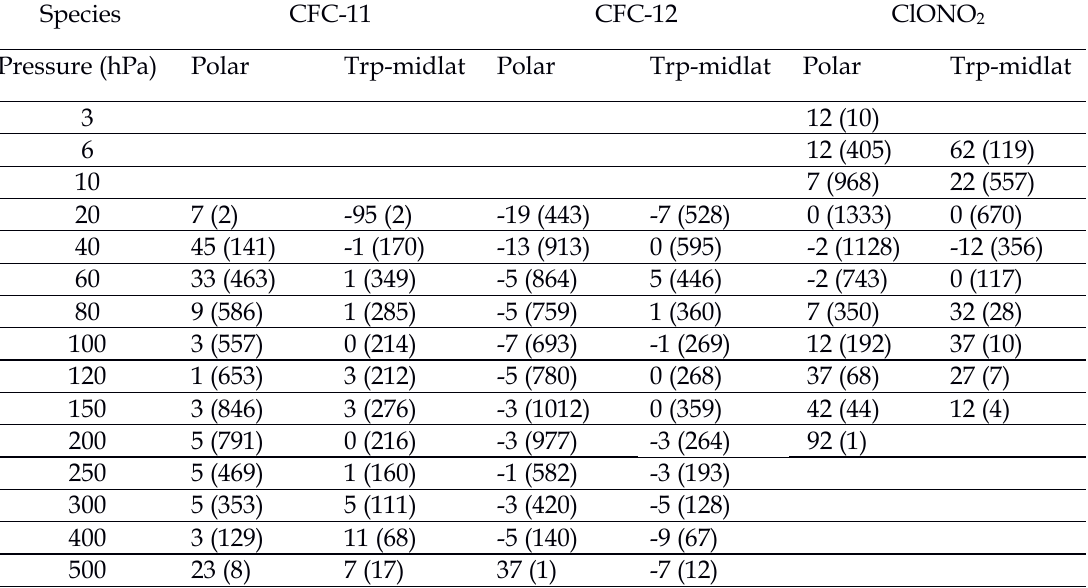
Table 1: Percentage median of the differences between MIPAS2D and ACE-FTS. The parenthetical values are the number of coincidences.